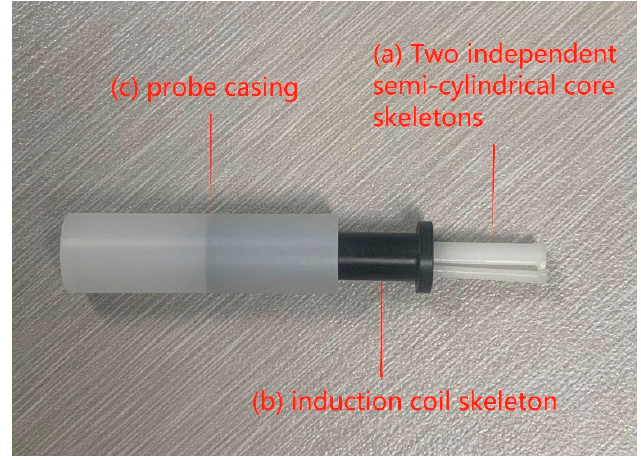
Figure 4. Photo of the probe structure. ( a ) Two independent semi-cylindrical core skeletons; ( b ) induction coil skeleton; ( c ) probe casing.